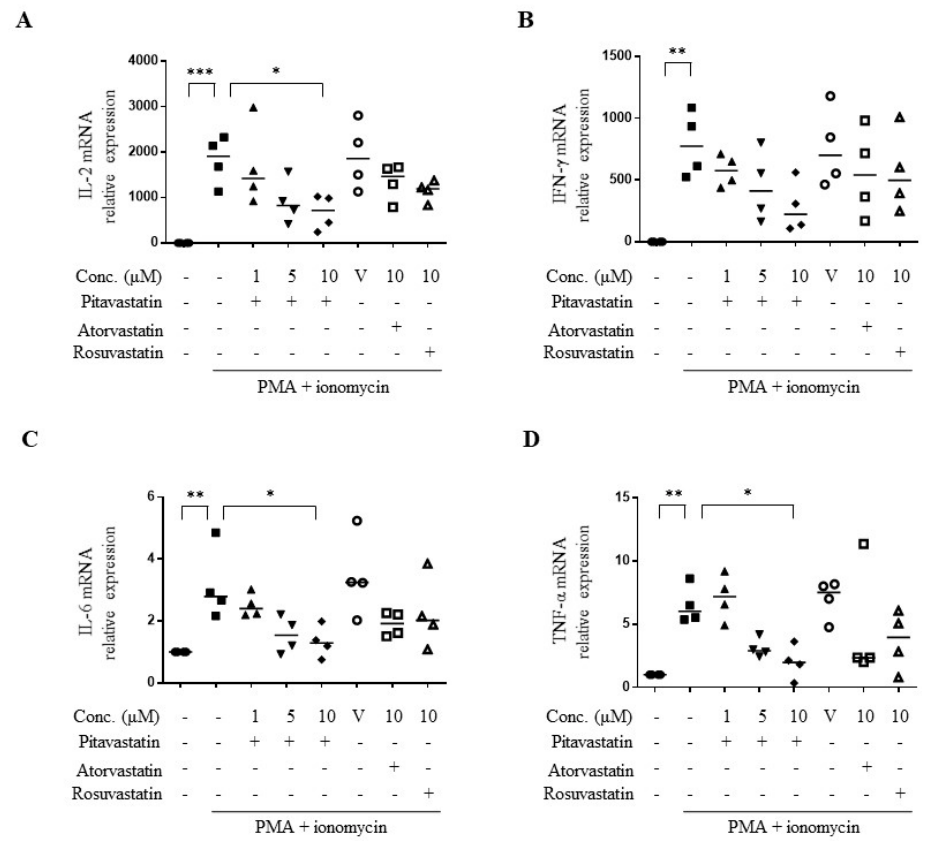
Figure 2. Pitavastatin dose-dependently inhibited de novo synthesis of pro-inflammatory cytokines in PMA + ionomycin-activated primary T cells. ( A – D ) Human primary T cells were pretreated with indicated dose of pitavastatin, 10 µ M atorvastatin, or 10 µ M rosuvastatin, respectively, for 2 h. Following 22 h of PMA (5 ng / mL) + ionomycin (1 µ M) stimulation, cells were collected for quantitative real time polymerase chain reaction (qRT-PCR) analysis for IL-2 ( A ), IFN- γ ( B ), IL-6 ( C ), TNF- α ( D ) mRNA expression. V indicates vehicle control. Data were expressed as the median with individual data of four independent experiments. Significance were represented as * p < 0.05, ** p < 0.01, and *** p < 0.001 versus PMA + ionomycin-stimulated group).